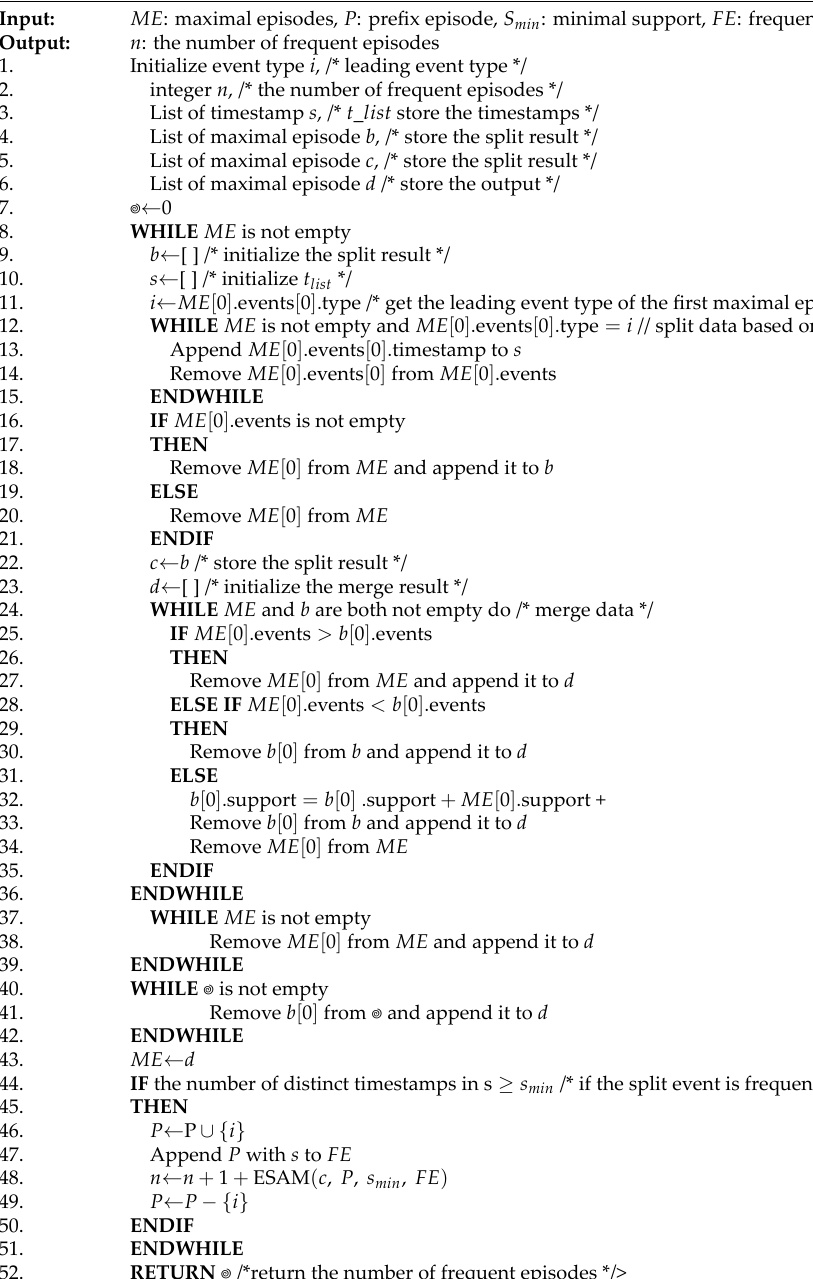
Algorithm 5 Extended Split and Merge